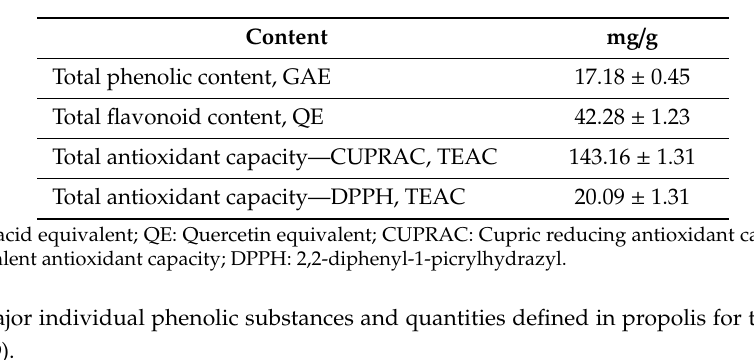
Table 5. The total phenolic and flavonoid content and antioxidant capacity of propolis for three parallel (Mean ± SD).